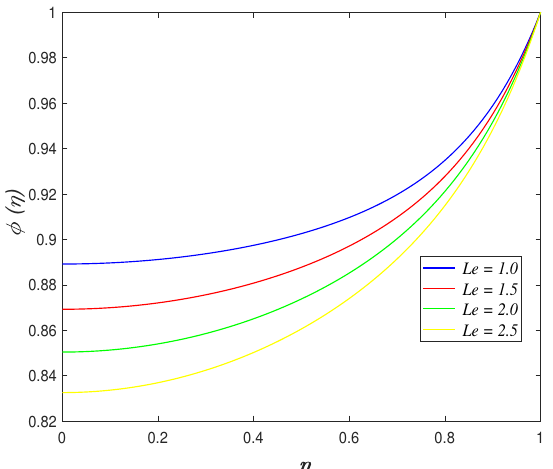
Figure 23. Impact of Le on concentration.